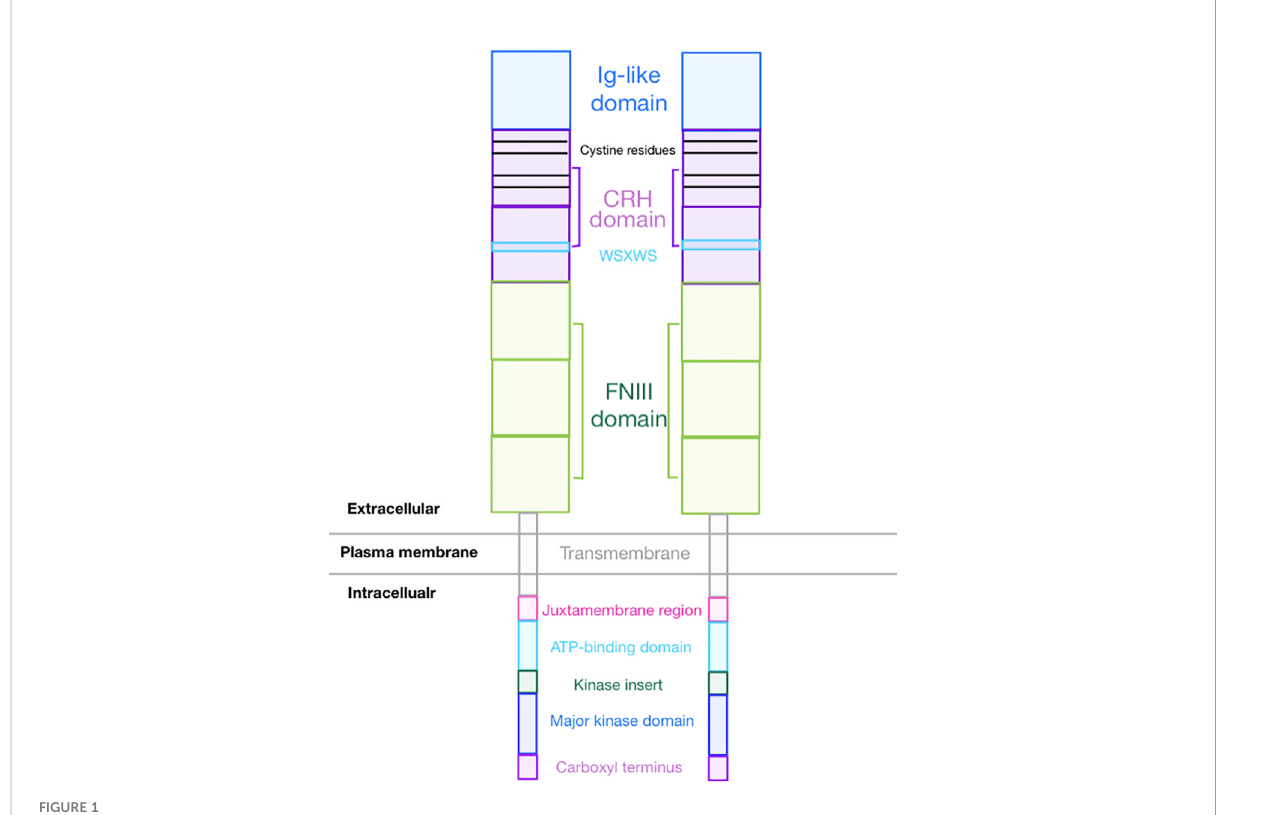
FIGURE 1 Overall GCSFR